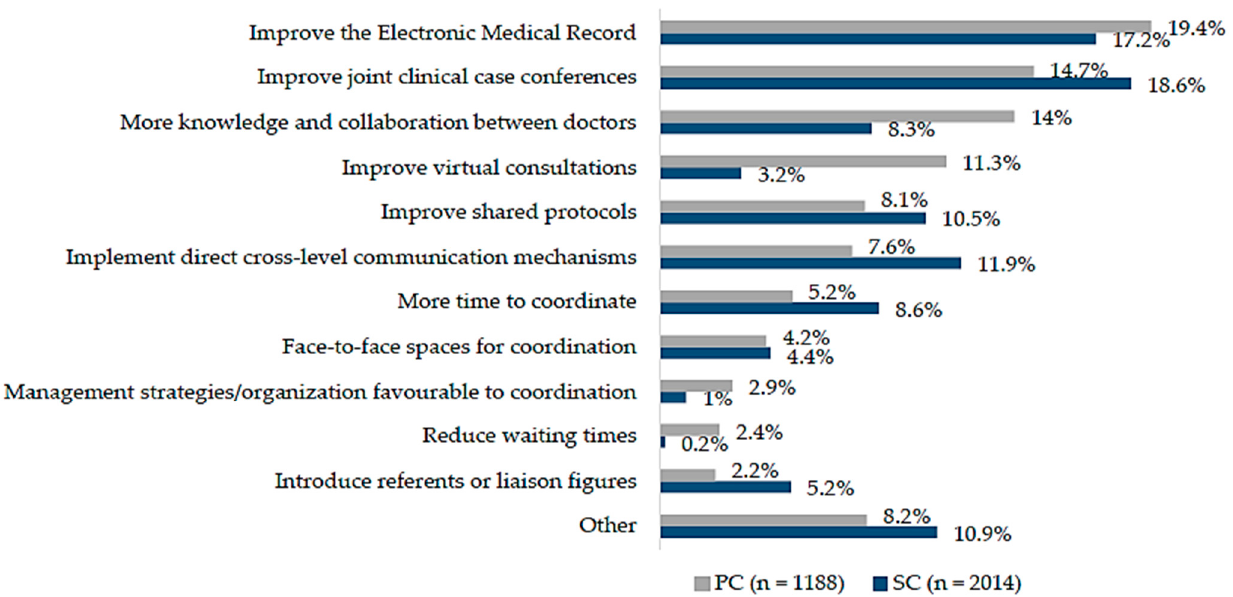
Figure 2. Suggestions for improvement of clinical coordination, by level of care; n : total of answers.